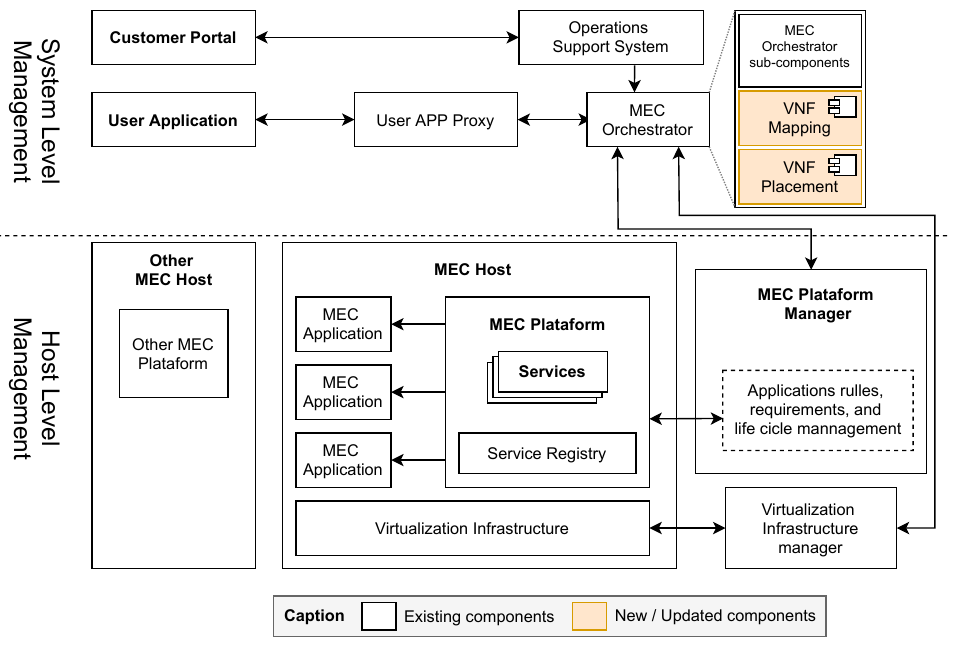
Figure 3. Architecture components of our